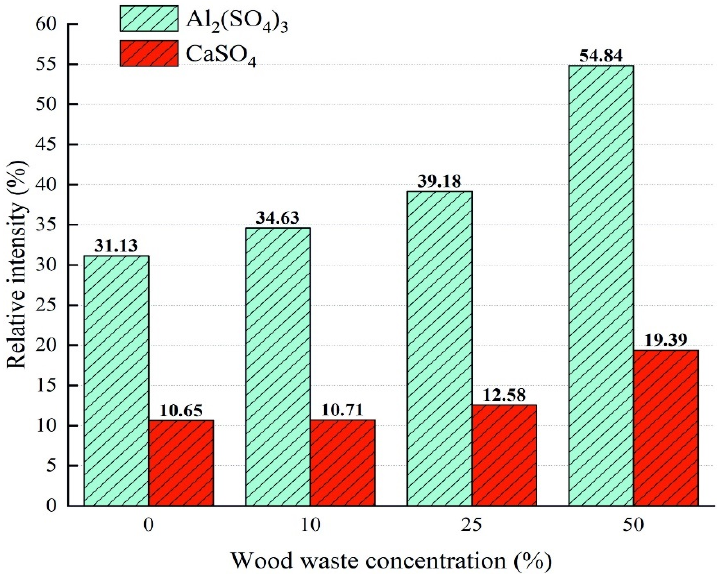
Figure 11. Changes in the content of calcium and aluminum sulfates in the ash of fuel mixtures based on metalignitous coal and wood with an increase in the proportion of wood in the initial mixture during pyrolysis in an inert medium at T = 873 K.